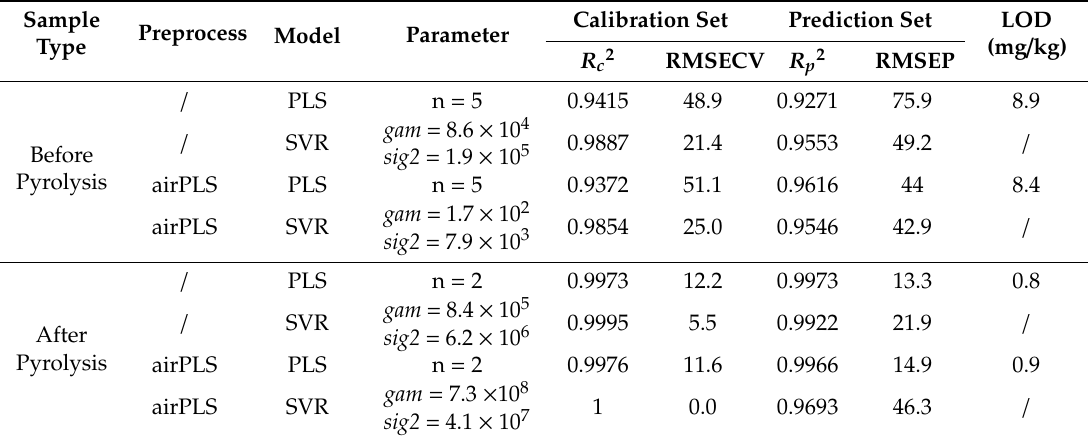
Table 3. The results of multivariate analysis based on full spectra by partial least squares (PLS) and support vector regression (SVR)